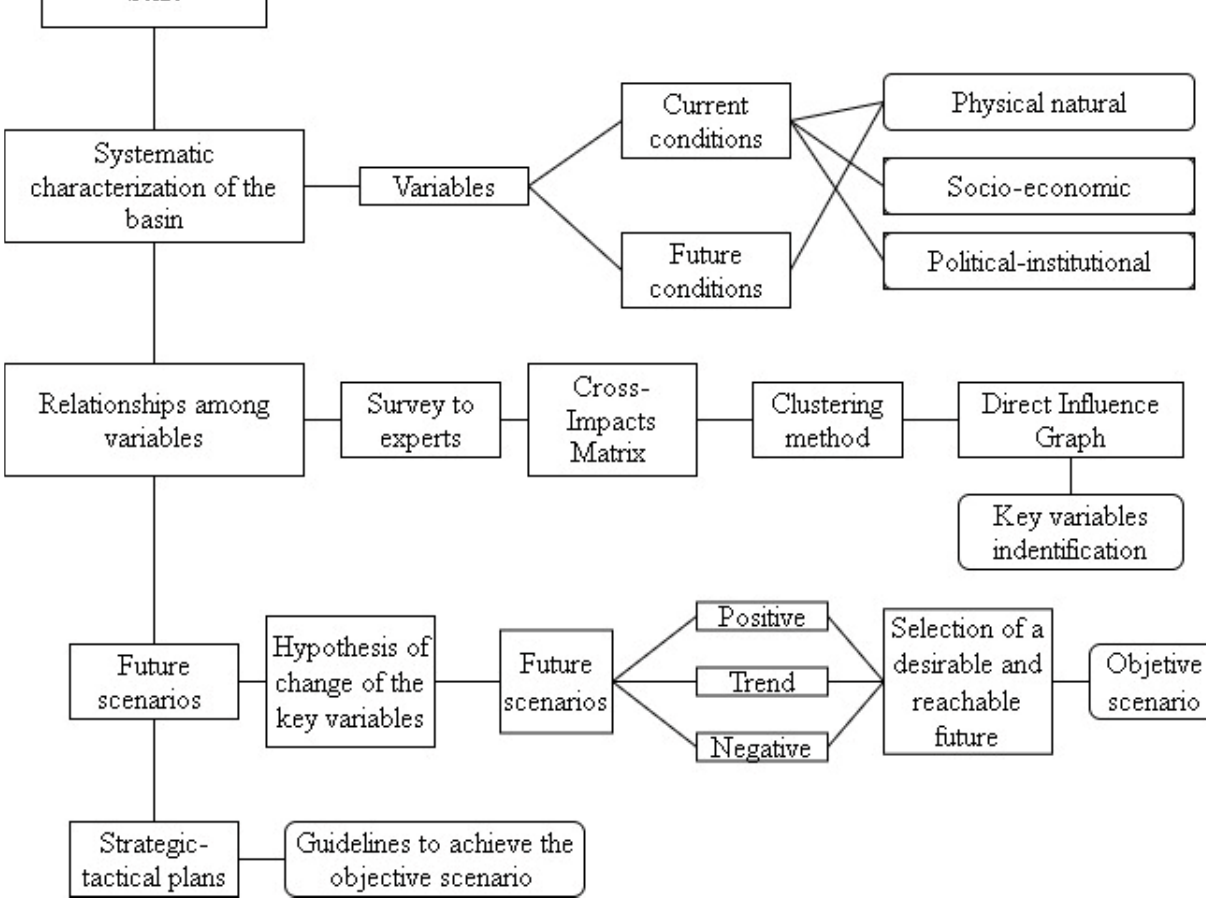
Figure 2. Flowchart showing the prospective analysis.